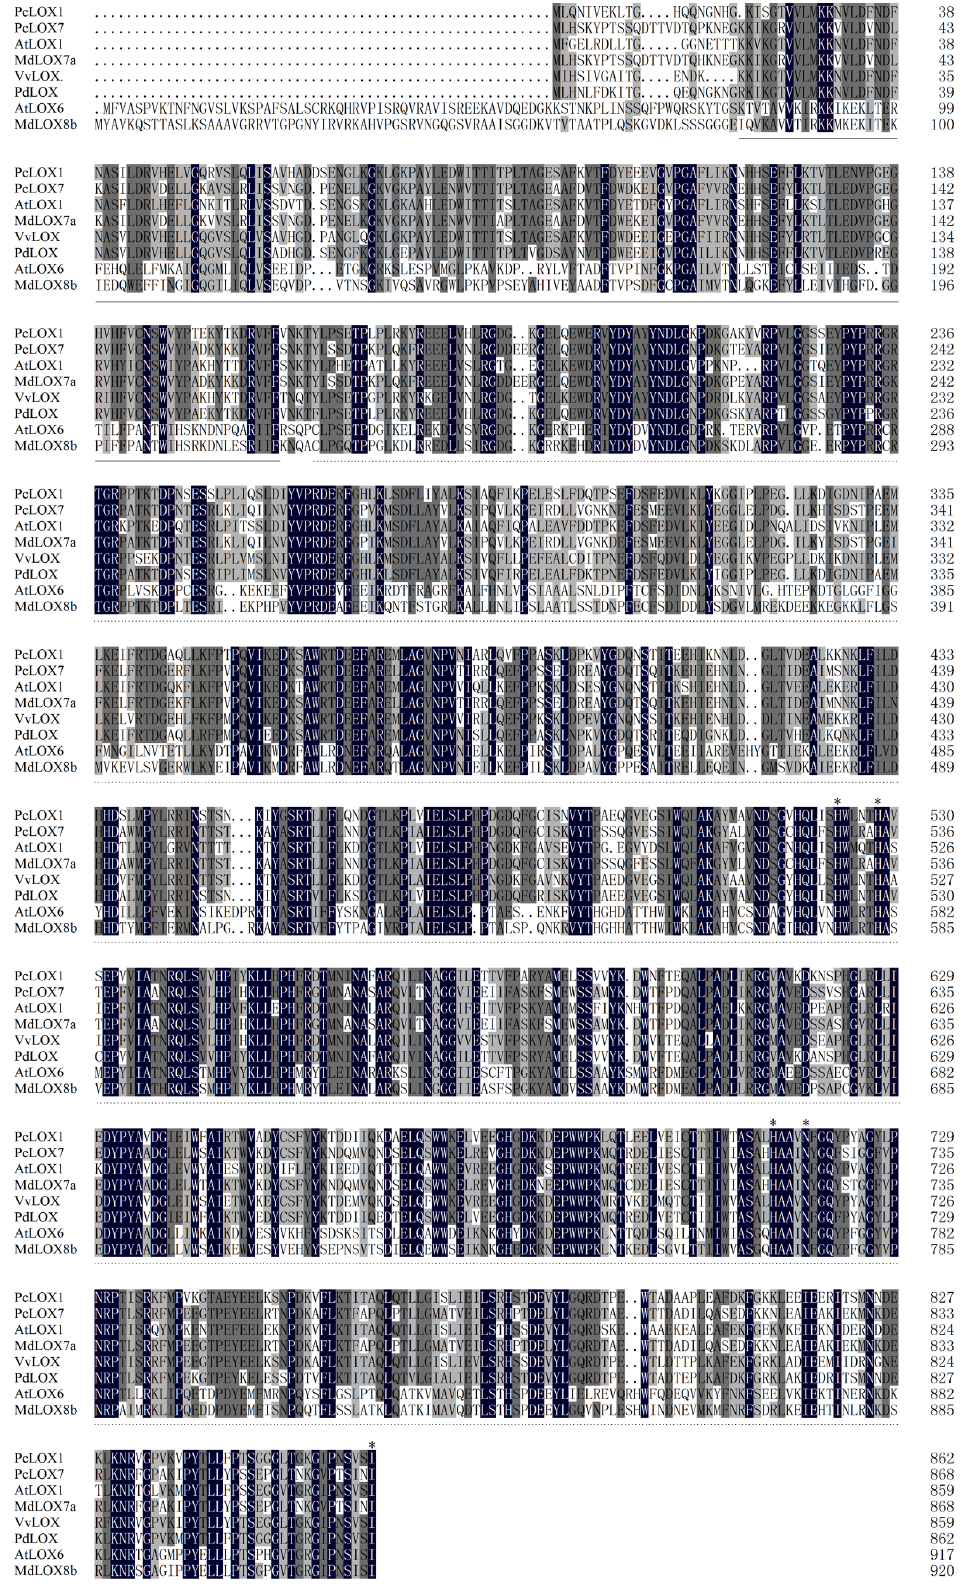
Fig. 1: Sequence alignment of eight plant LOX proteins. Identical amino acid sequences are highlighted in black, and sequence similarities are shown in grey. Solid line represents PLAT domain, dotted line represents lipoxygenase damain, and asterisks represent putative iron binding sites. The accession numbers of plant lipoxygenase proteins in GDR or GenBank are: Pyrus communis PcLOX1 (PCP003542), Pyrus communis PcLOX7 (PCP003539), Arabidopsis thaliana AtLOX1 (NP_175900), Malus domestica MdLOX7a (AGI16416), Vitis vinifera VvLOX (NP_001268178), Pru- nus dulcis PdLOX (CAD10779), Arabidopsis thaliana AtLOX6 (CAG38328), and Malus × domestica MdLOX8b